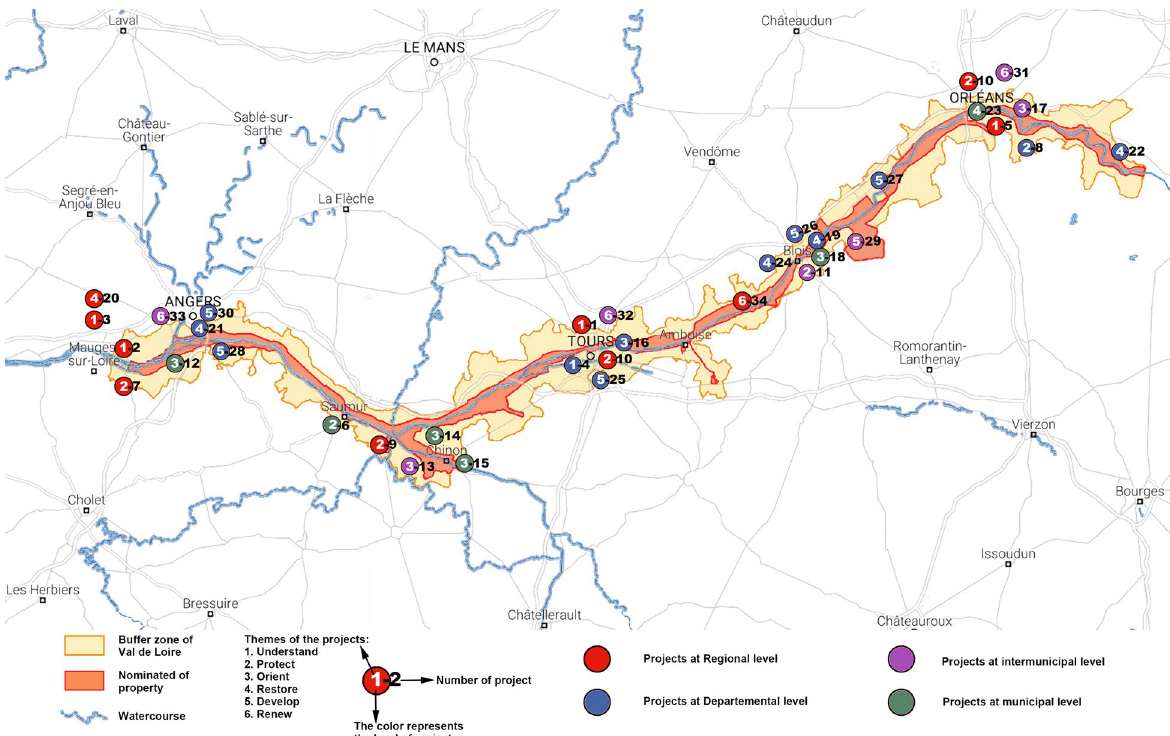
Fig. 10 Location of 34 projects in the Val de Loire site (when the project involves more than one municipality, the mark for the project on the map indicates the location of the institution in charge of the project instead of the location of the project itself), (Source: Peng 2020). Reference: Cahier du Val de Loire n°3 (2005), background map: